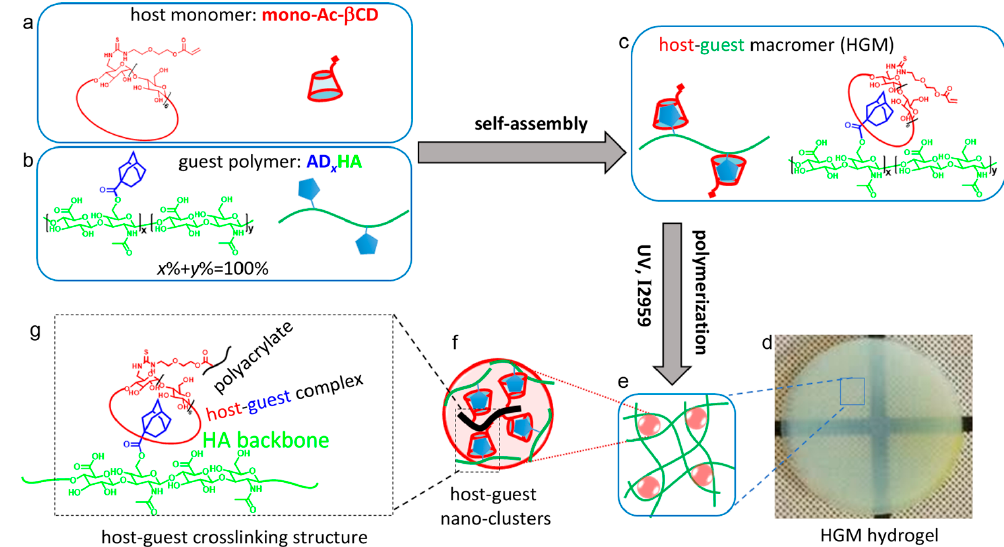
Figure 4. Chemical illustration of: ( a ) the host monomer (mono-Ac- β CD); ( b ) the guest polymer (AD x HA); and ( c ) the host–guest macromer (HGM). ( d – g ) Representation of various hydrogel/host– guest structures. Reproduced from [48] with permission. Copyright 2016 American Chemical